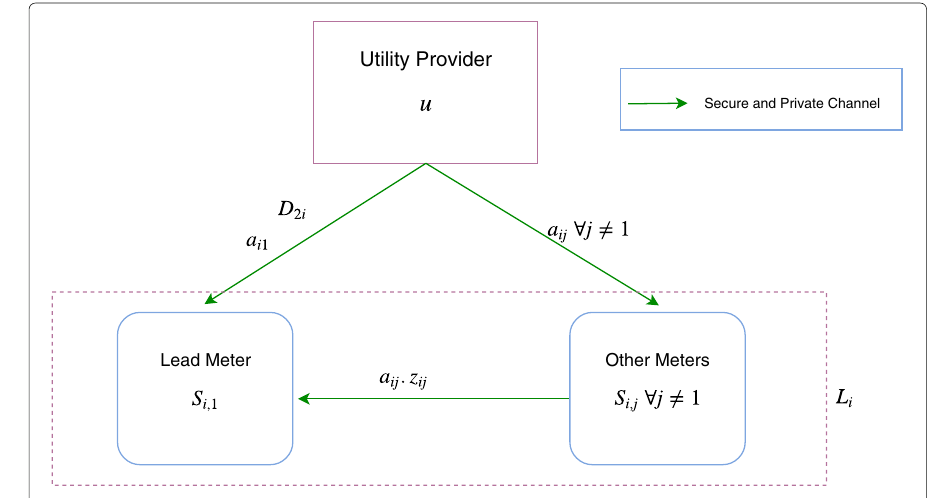
Fig. 2 A triangular key distribution scheme for a locality L i